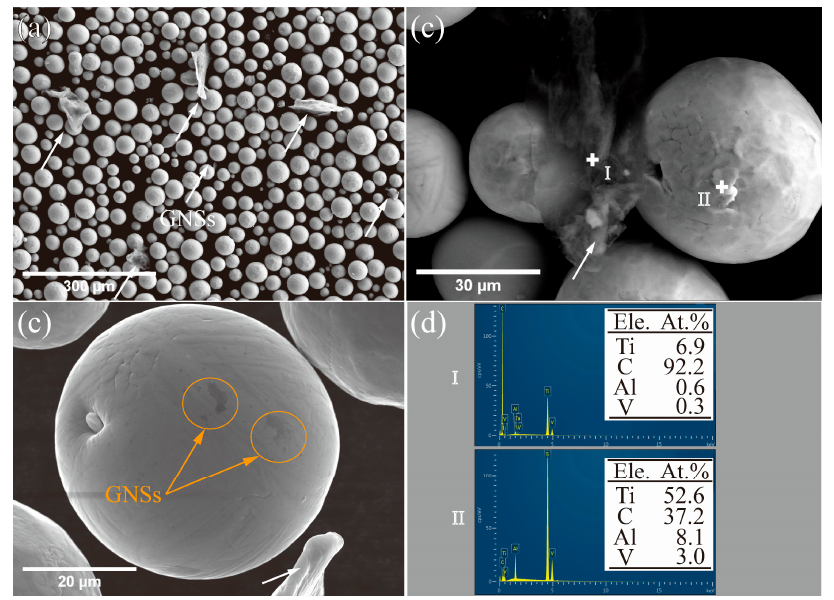
Figure 4. SEM images of #1 GNSs/Ti64 composite powders via rocking milling ( a ), GNSs among powders ( b ), GNSs on the surface ( c ), and EDS spectra ( d ).